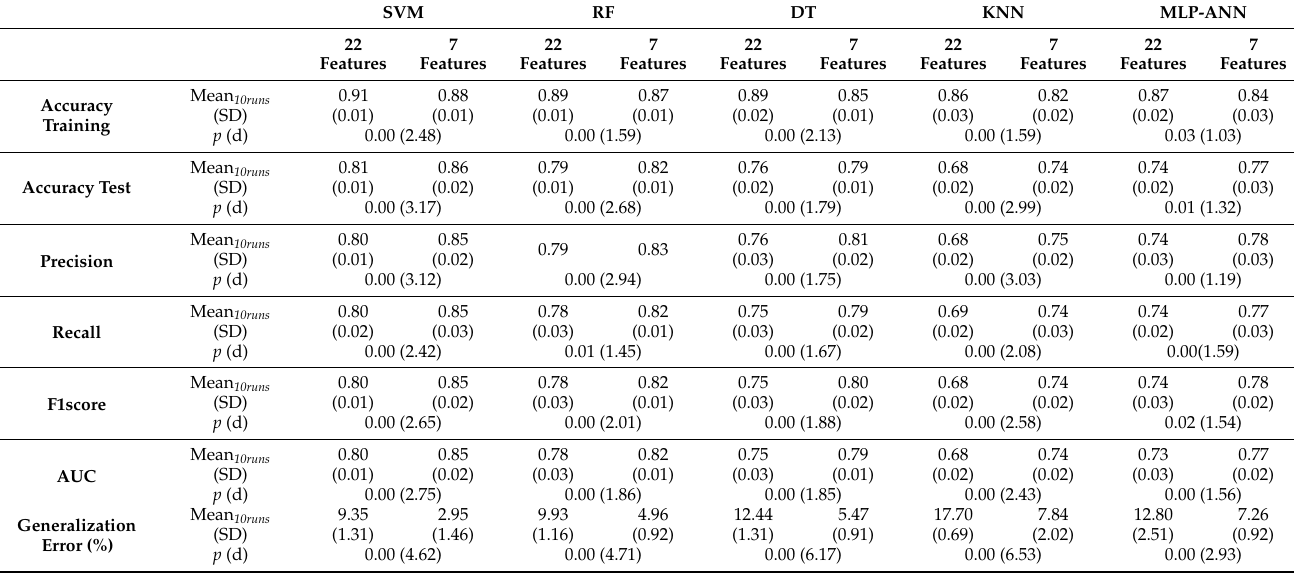
Table 2. Comparison of the classification performances of the supervised machine learning accuracies between the 22-features and the 7-features models.